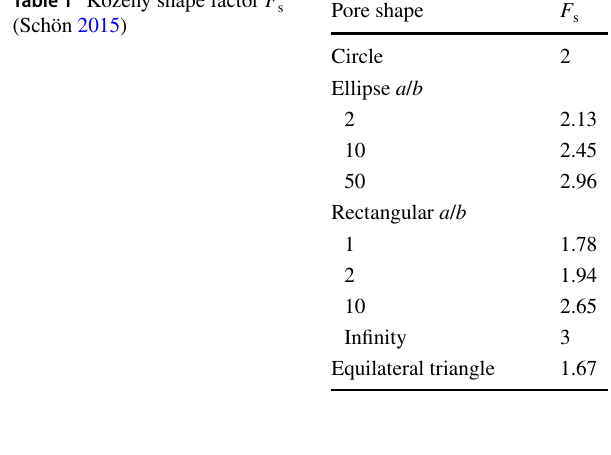
Table 1 Kozeny shape factor F